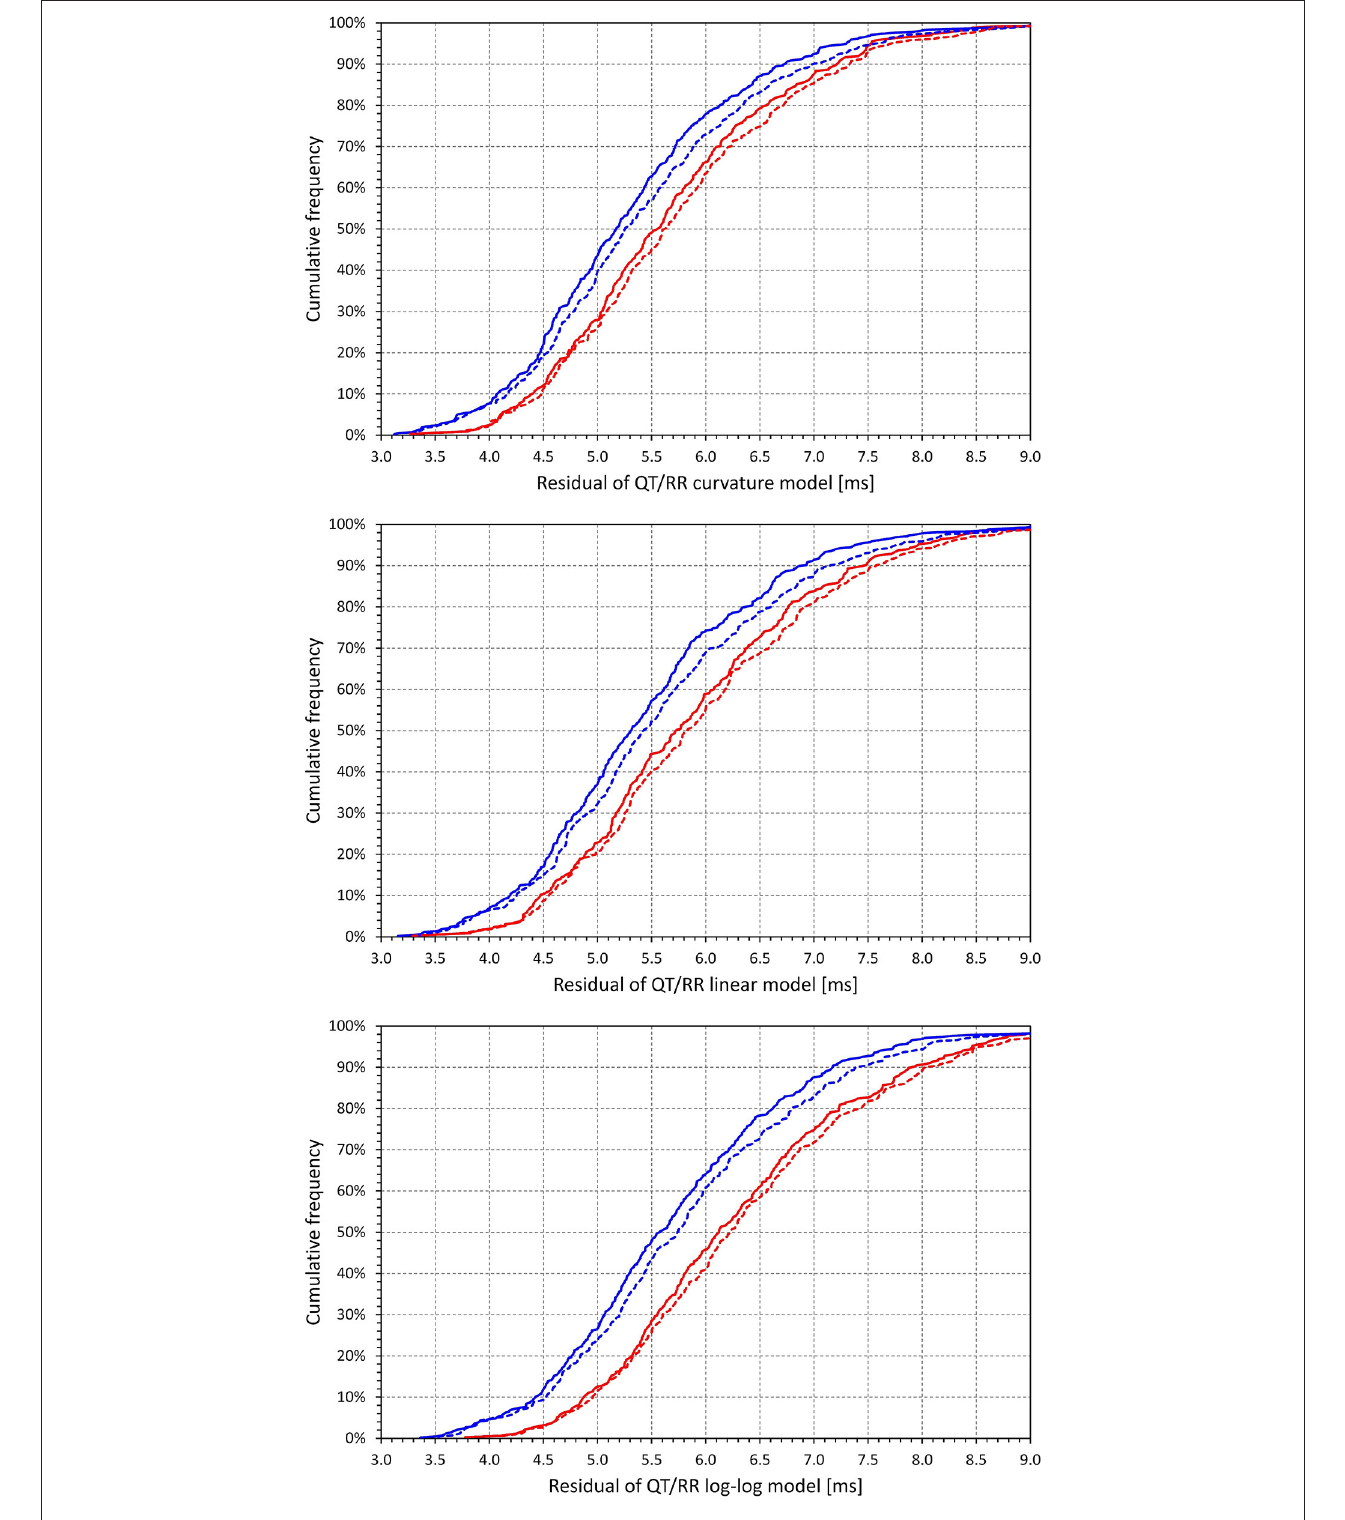
FIGURE 3 | Cumulative distributions of intra-subject residuals of QT/RR H regression models for the curvature model (top panel), linear model (middle panel), and log-log model (bottom panel). In each of the panels, the red and blue lines correspond to females and males, respectively; the full and dashed lines correspond to the time-based and interval-based QT/RR hysteresis models,